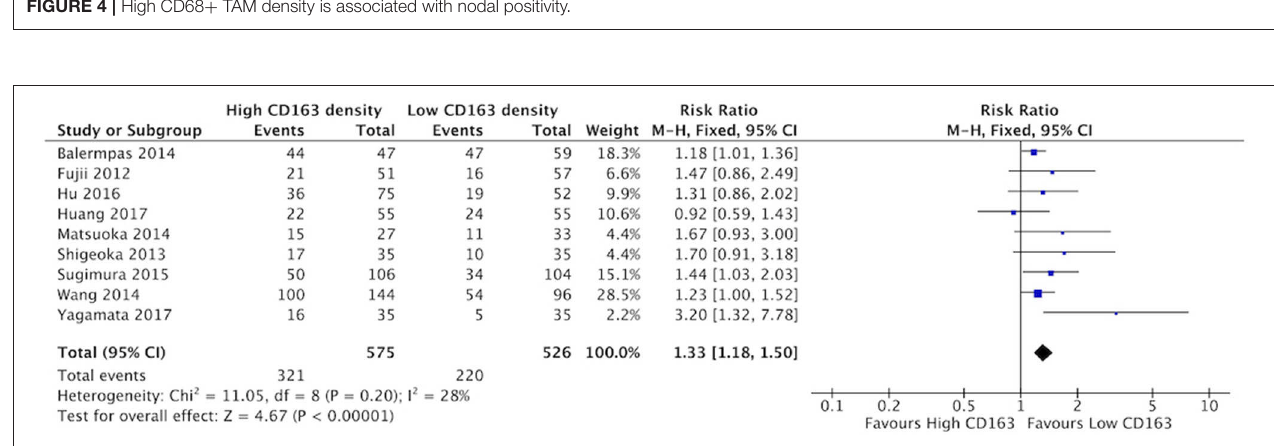
FIGURE 4 | High CD68 + TAM density is associated with nodal positivity.